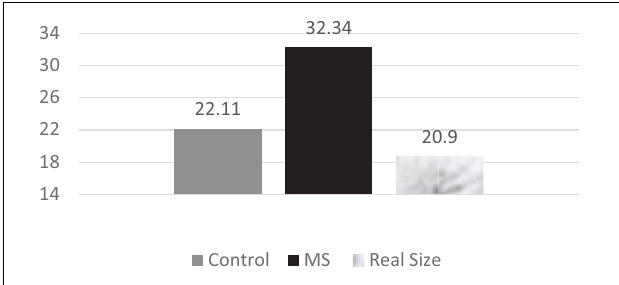
FIGURE 2 | Participants’ estimation of the percentage of Arabs in the general Israeli population compared to the actual percentage (Israel Central Bureau of Statistics,